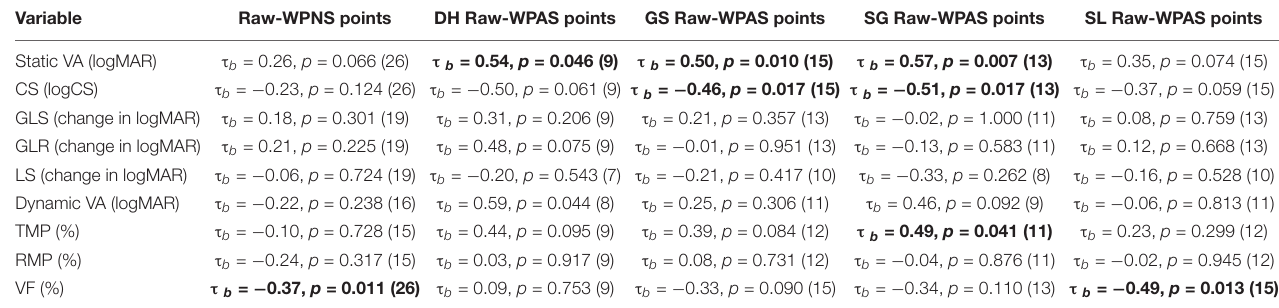
TABLE 4 | Summary of correlations of visual functions with skiing performances; p -values are presented in the table with sample sizes, and significant correlations are provided in bolded